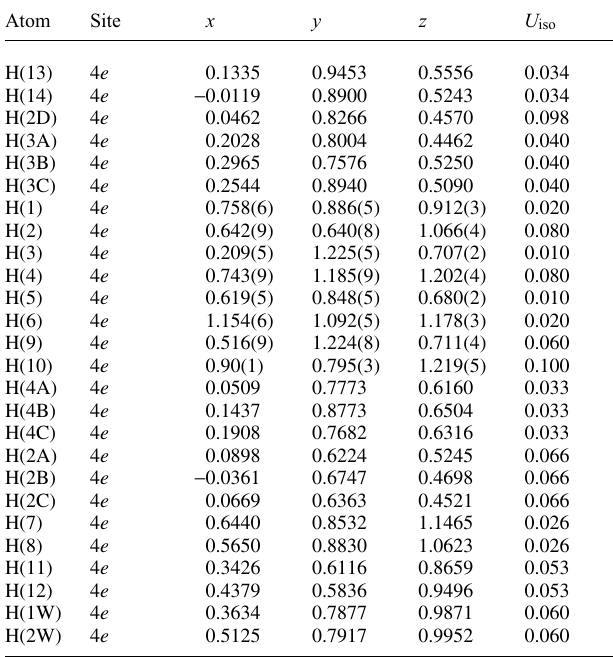
Table 2. Atomic coordinates and displacement parameters (in Å 2 ) .